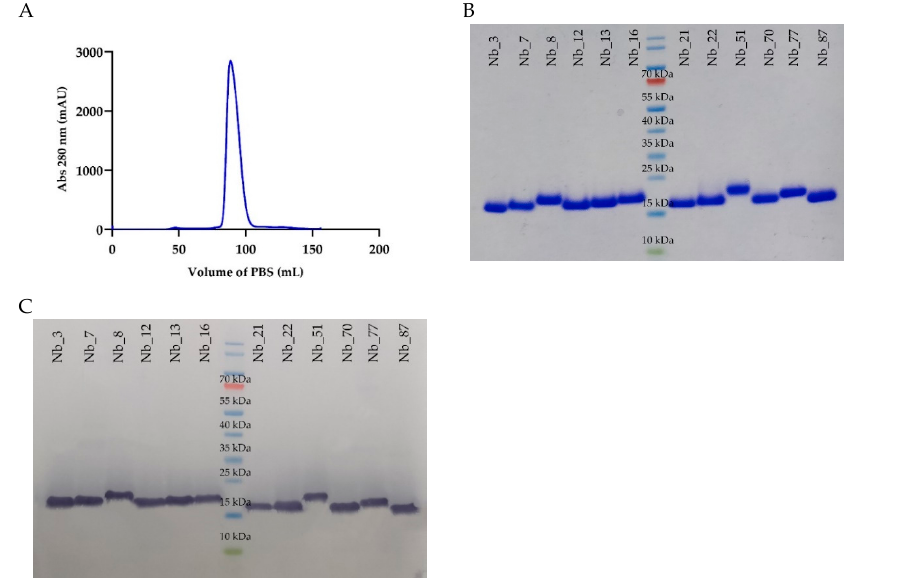
Figure 2. Purity of the anti-CD33 Nb preparations. ( A ) SEC profile of the Nb_12, showing a single peak of protein. (All other Nbs gave comparable chromatograms). ( B , C ) SDS-PAGE under reducing conditions, where proteins are revealed after staining with Coomassie blue ( B ) or by western blot, using a mouse anti-HA tag monoclonal antibody and a goat anti-mouse IgG horse radish peroxidase (HRP)-conjugated antibody ( C ). For both staining conditions and for each Nb preparation, only one single band was